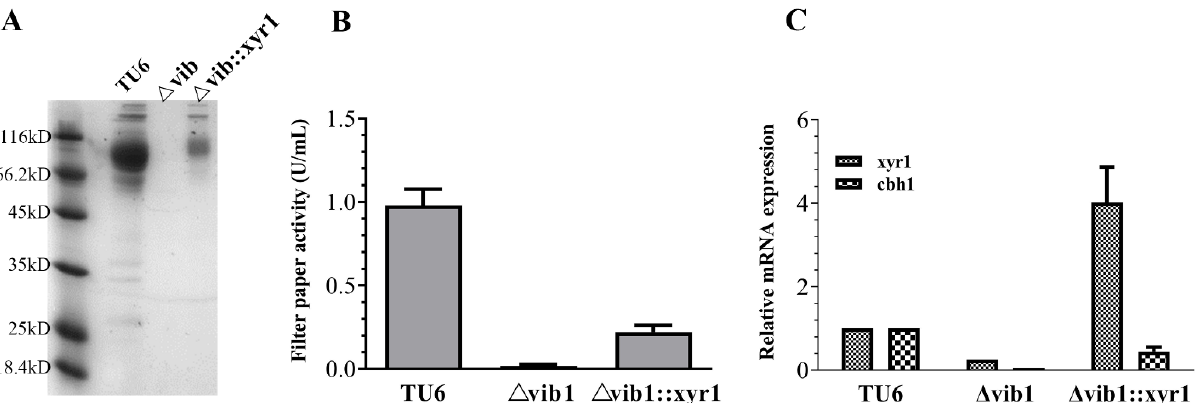
Figure 4. Constitutive expression of xyr1 partially restored cellulase production of the Δ vib1 mutant on Avicel. The secretomes ( A ) and cellulase activity ( B ) of the culture supernatant in TU6, Δ vib1 , and Δ vib1 :: xyr1 120 h after transfer to Avicel cellulose from glucose. ( C ) RT-PCR measurement of xyr1 and cbh1 expression in TU6 versus Δ vib1 and Δ vib1 :: xyr1 24 h after transfer to Avicel cellulose from glucose. Expression level was normalized to the parent strain TU6.